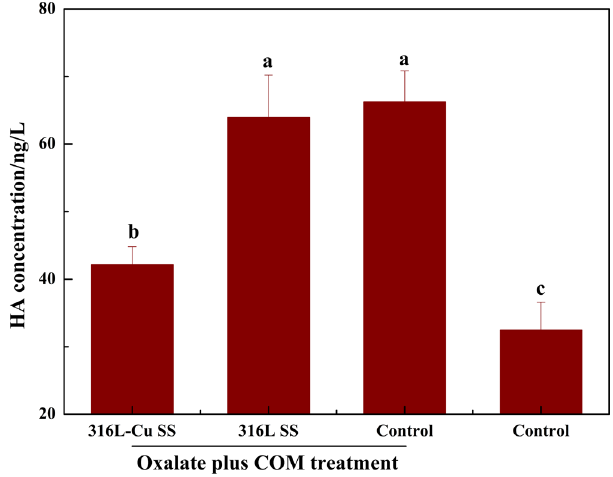
Figure 4. Concentrations of ROS after different treatments of UECs for 24 h. Data are presented the as mean ± SD. A significant difference at p < 0.05 is shown with different letters.